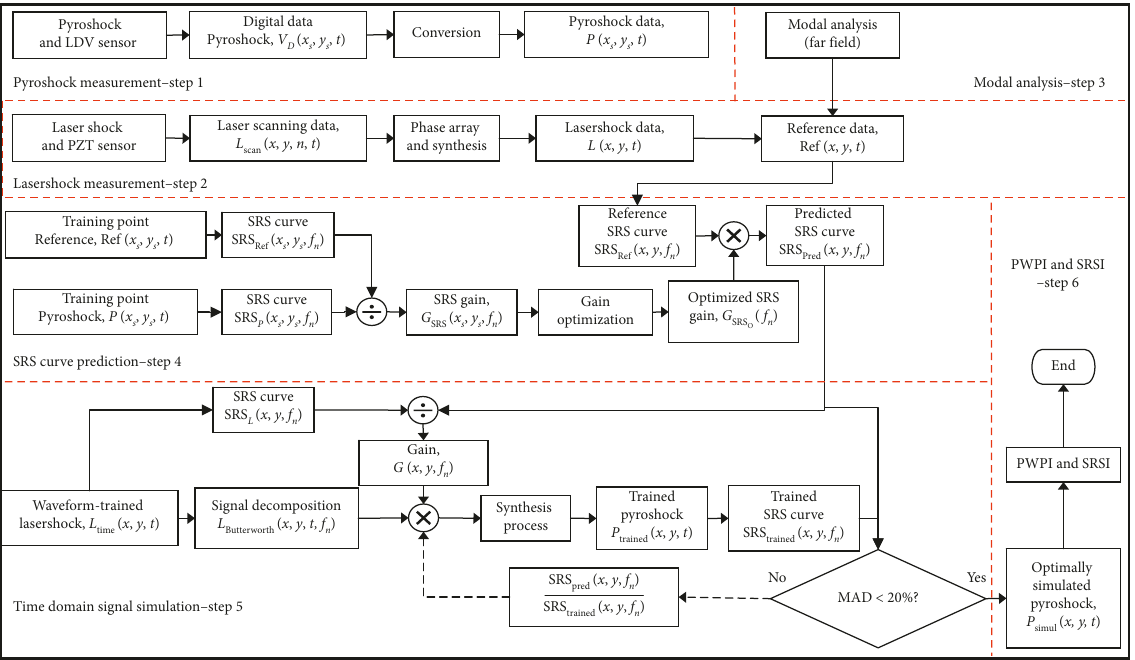
Figure 2: Flow chart of the hybrid method of FEM-based modal analysis and laser shock scanning-based simulation (PWPI: pyroshock wave propagation imaging; SRSI: shock response spectral